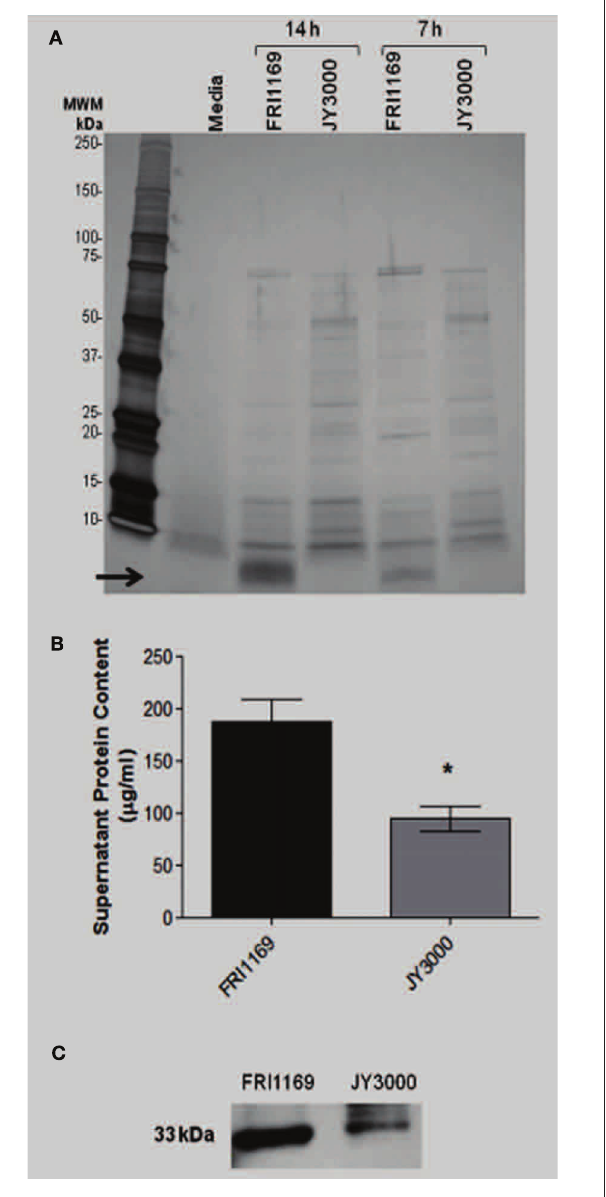
FIGURE 2 | Characterization of exoprotein production by wildtype FRI1169 and variant JY3000. (A) 14 and 7h broth culture supernates (20 μ g of protein loaded per lane) were separated by SDS-PAGE and silver-stained. Media denotes lane electrophoresed with Todd Hewitt media alone. Arrow denotes small molecular weight ( < 10kDa) band only present in FRI1169 cultures. (B) Total protein content measured in three separate overnight broth culture supernates from JY3000 and FRI1169 via Bio Rad reagent. ( ∗ P = 0 . 005 by Student’s t -test). (C) Western immunoblot results showing differences in α -toxin amounts produced by wildtype FRI1169 and